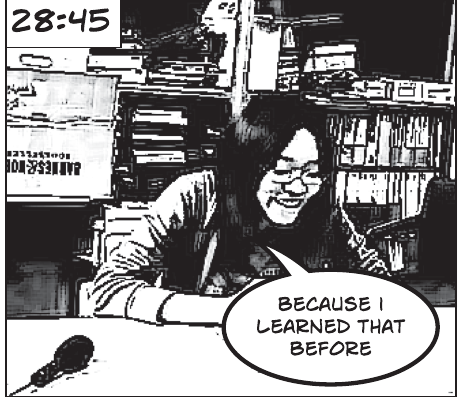
FIG. 6. Judy displays positive emotions in facial expressions as she works on the extended resistor